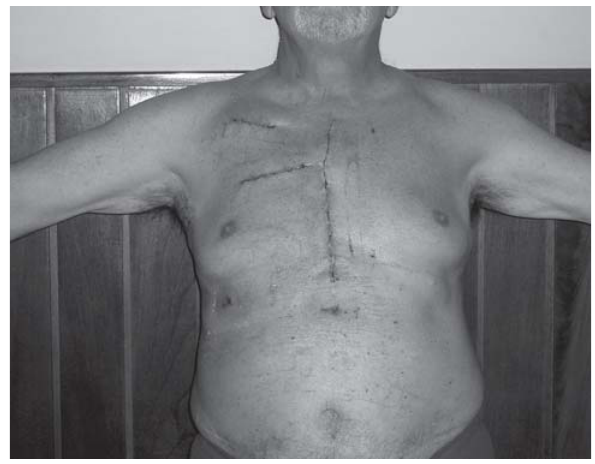
Fig. 5 - Postoperative photograph of the patient’s chest prior to discharge, showing both scars from both surgeries: anterior mediastinal and the right parasternal